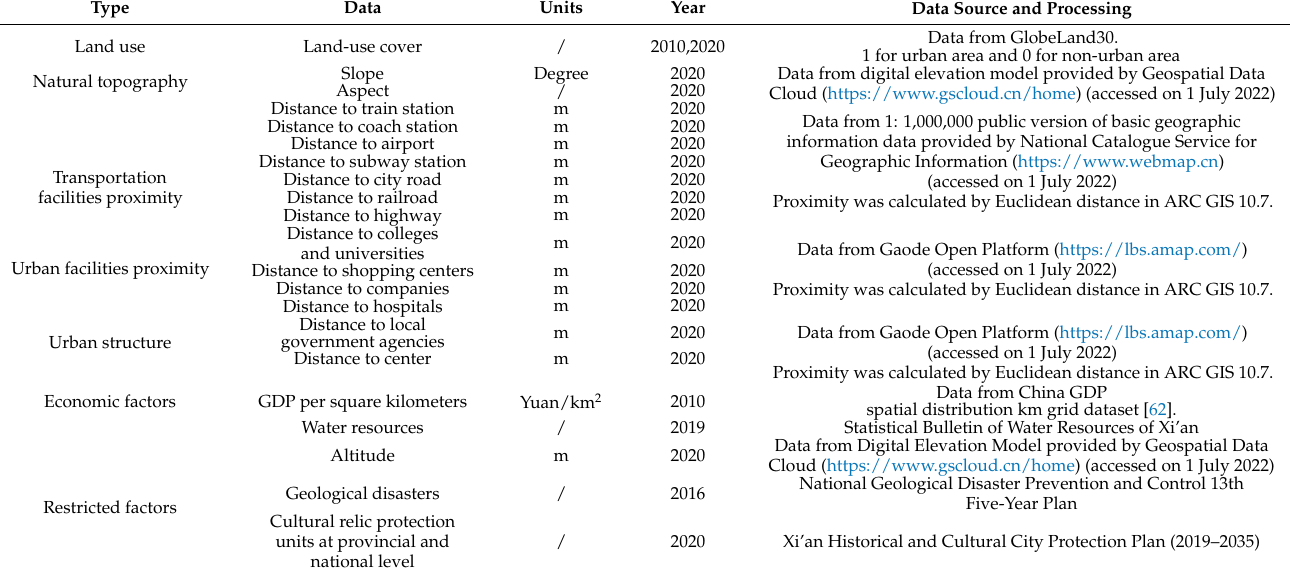
Table 1. Data source of land-use and driving